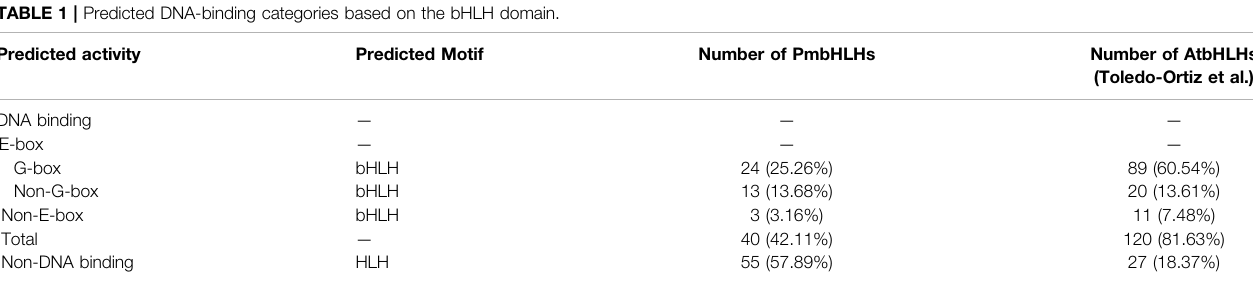
TABLE 1 | Predicted DNA-binding categories based on the bHLH domain. Predicted activity Predicted